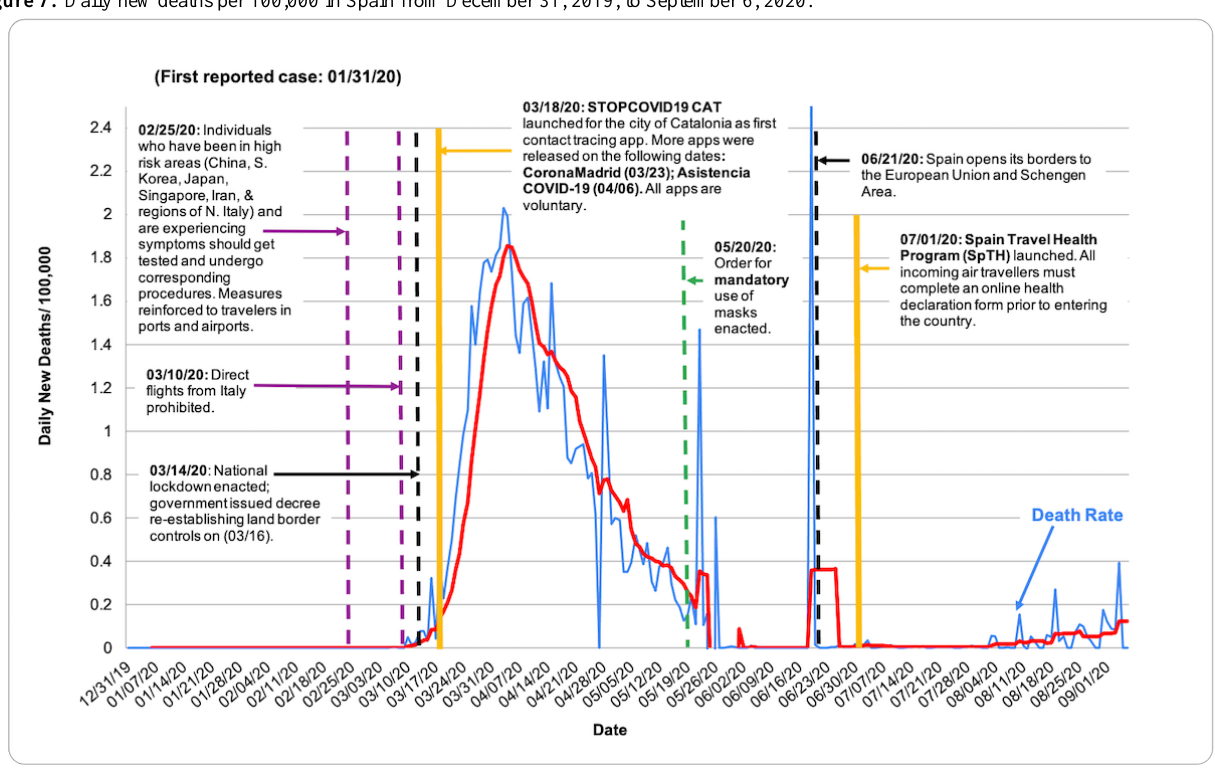
Figure 7. Daily new deaths per 100,000 in Spain from December 31, 2019, to September 6,